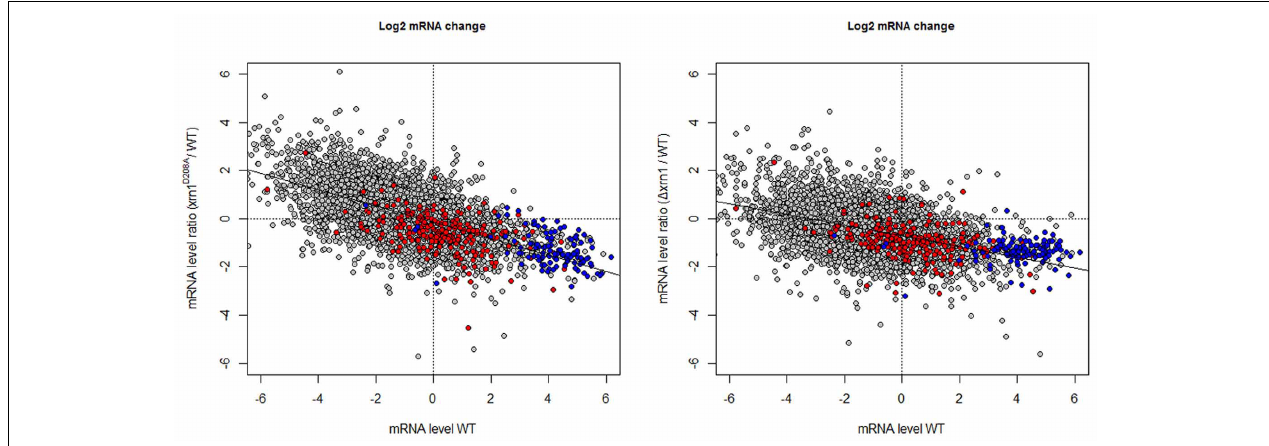
FIGURE 3 | Changes in the mRNA level in xrn1 mutants inversely correlate with the mRNA level. Plots of the ratios between the mutant and the wt mRNA level against the mRNA level in the wt. See Figure 1 for other details.